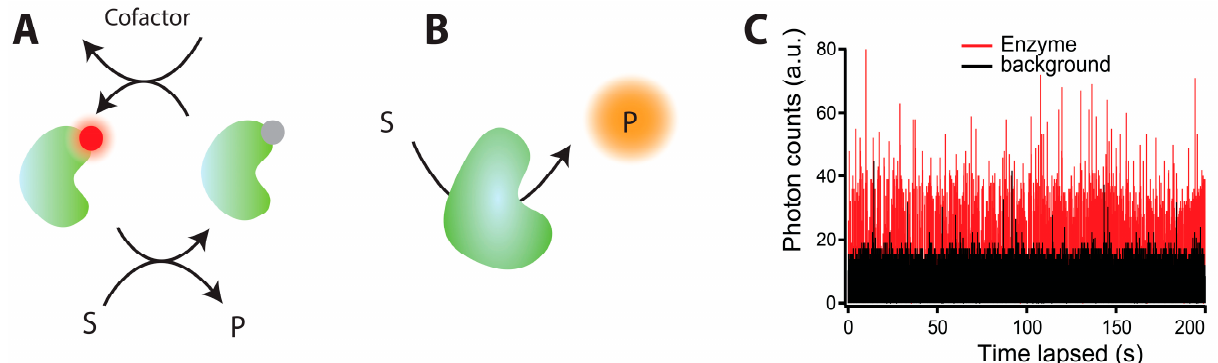
Figure 4. A general description of the methodology to attain single turnover resolution measurements. ( A ) A method exploiting fluorescence property changes within each catalytic cycle of cofactors or covalently attached fluorophores; ( B ) Prefluorescent substrate analogues for prolonged observation of individual catalytic turnovers. The non- fluorescent substrate is converted by the enzyme to the highly fluorescent product, which subsequently diffuses away from the detection volume allowing recordings of individual catalytic cycles. Being limited only by substrate depletion this methods allows recordings of thousands of catalytic cycles for accurate statistical analysis; ( C ) A typical single molecule activity trace of lipase converting a prefluorescent substrate analogue, here CFDA, to highly fluorescent carboxy-fluorescein (red trace). Each spike corresponds to an individual catalytic cycle. The black trace corresponds to the background signal (Figure 4C reprinted with permission from [17]. Copyright (2012) American Chemical